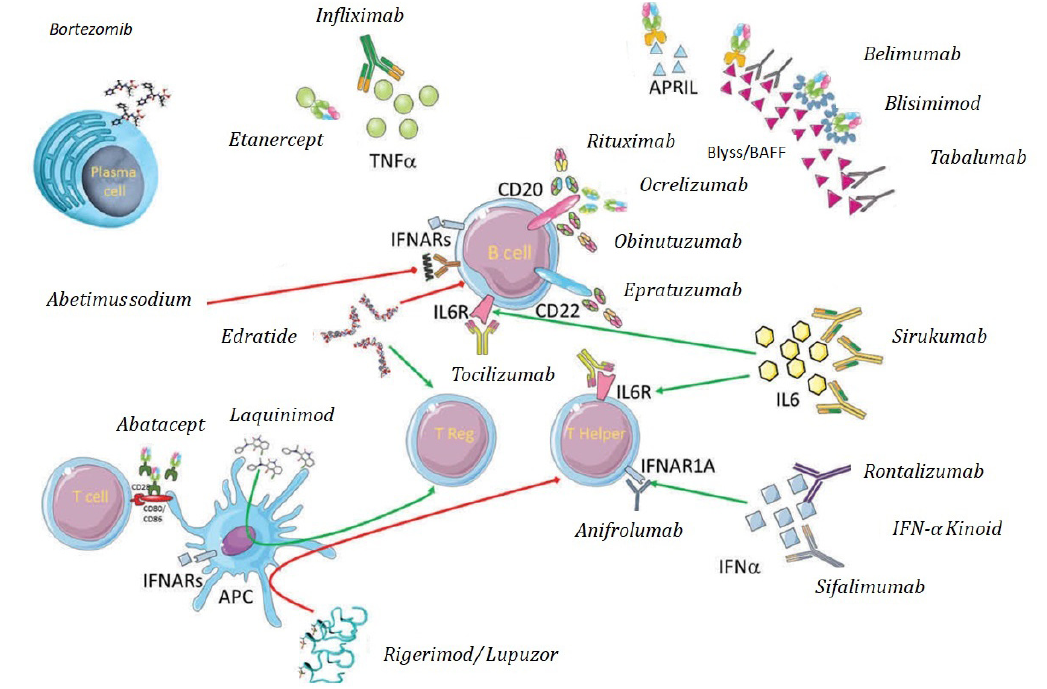
Figure 1. Targeted biological agents available and in ongoing phase II and III trials of systemic lupus erythematosus.